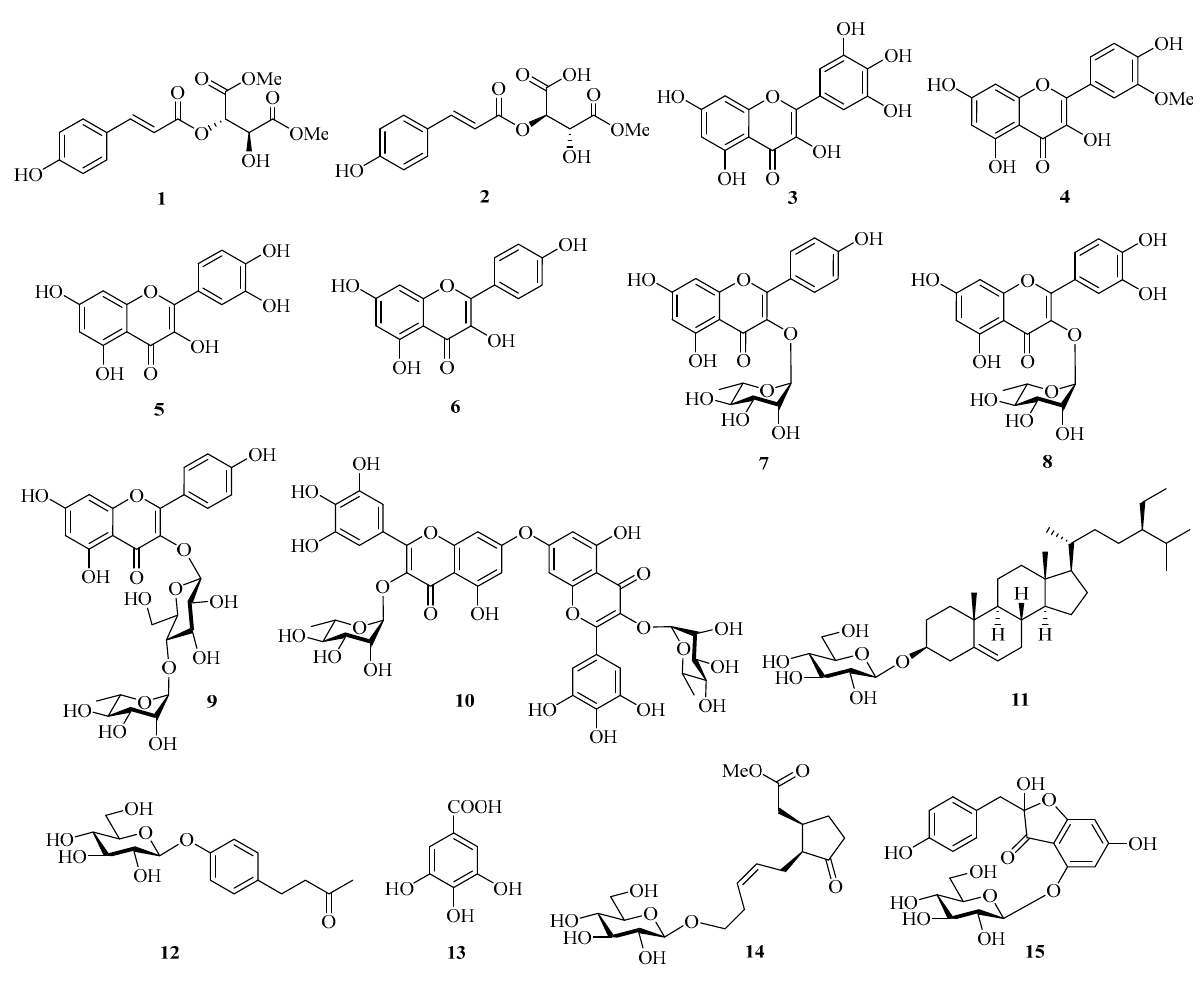
Figure 1. Structures of compounds 1 – 15 .